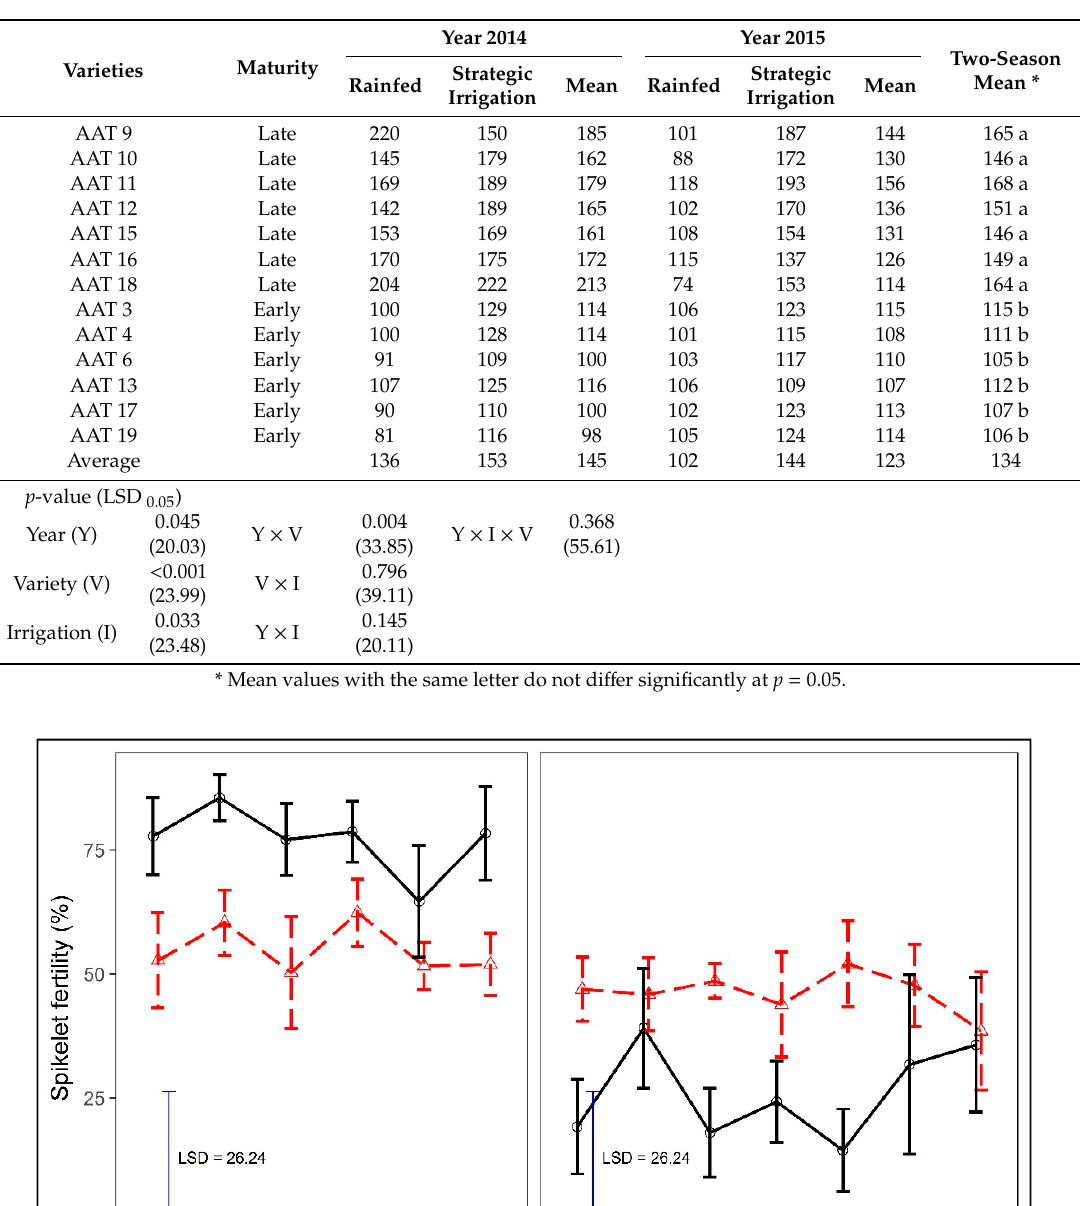
Table 5. Total spikelets per panicle of rice varieties under strategic irrigation and rainfed conditions in Alton Downs, 2014 and 2015.